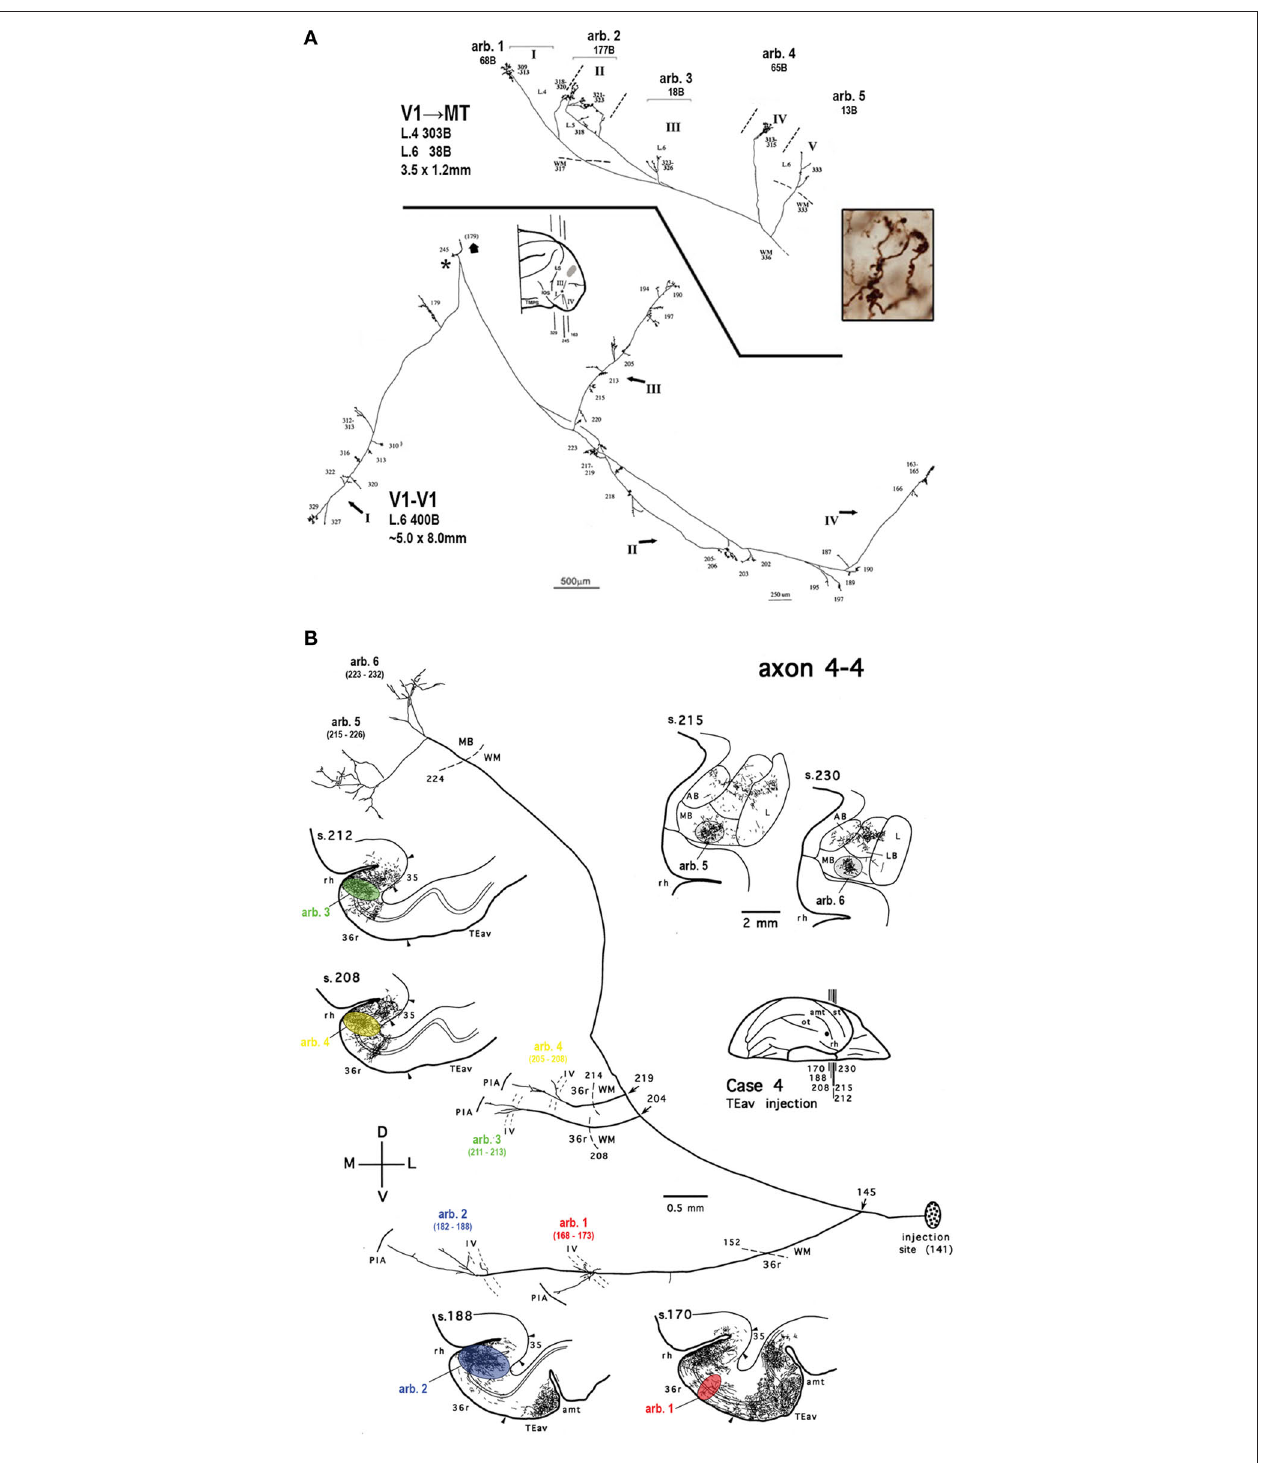
hemisphere, and the approximate position of the collaterals is indicated by I–IV. A BDA injection site is indicated by the shaded oval. Terminal specializations in MT are illustrated in the inset. Modified from Figure 1 of Rockland (2002). (B) A neuron anterogradely labeled by an injection of PHA-L in macaque area TEav has four arbors in adjoining parts of area 36, and two additional arbors in the amygdala. Arbors were followed to denser projection patches (color-coded in selected coronal sections) in different sections. Sections correspond to the numbered lines on the schematic of the monkey hemisphere. Modified from Figure 12 of Cheng et al.